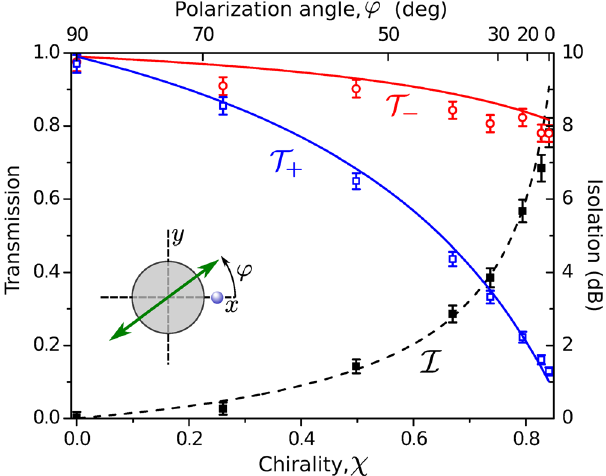
FIG. 3. Nonreciprocal transmission of chiral photons that interact with an ensemble of spin-polarized atoms. Transmissions T T (blue) and isolation I (black dashed line) as a − (red) and þ function of the chirality χ , calculated at the position of the atoms. The lines are the result of a numerical calculation with h N i ≈ 27 . The error bars indicate the 1 σ statistical error based on counting statistics. Inset: Cross section of the optical nanofiber (gray disk) including the trapped atoms (blue sphere) and the main polari- zation axis of the guided field (green double arrow). The main polarization axis of the guided field and the x axis enclose the angle φ .